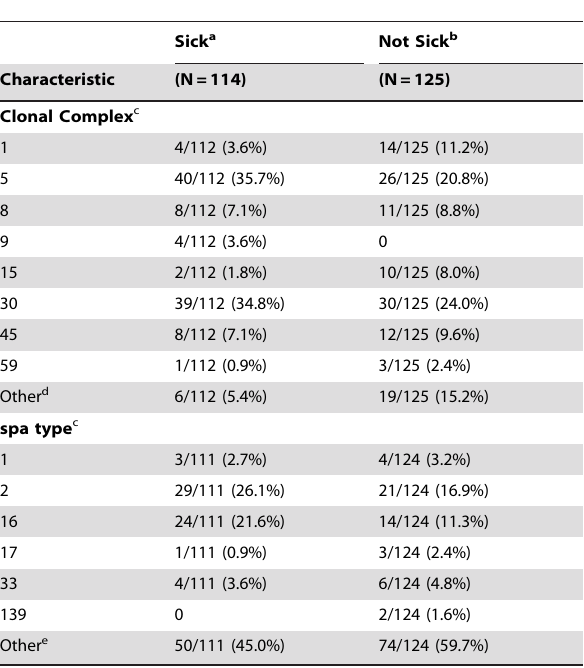
Table 1. Genotypic characteristics of 239 study